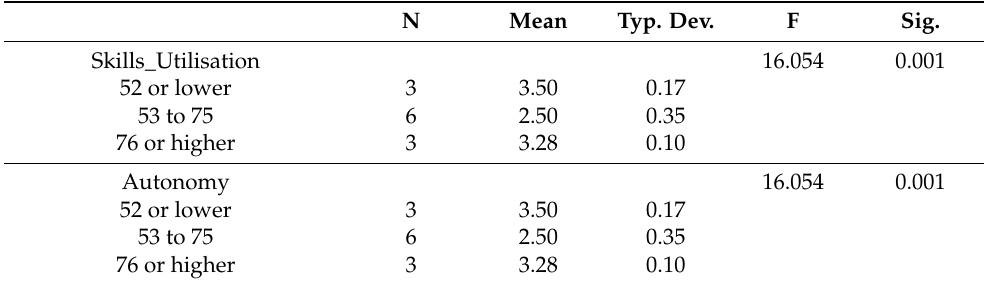
Table 12. Descriptive statistics and significance of the differences in demands and work resources based on the severity of the disability.